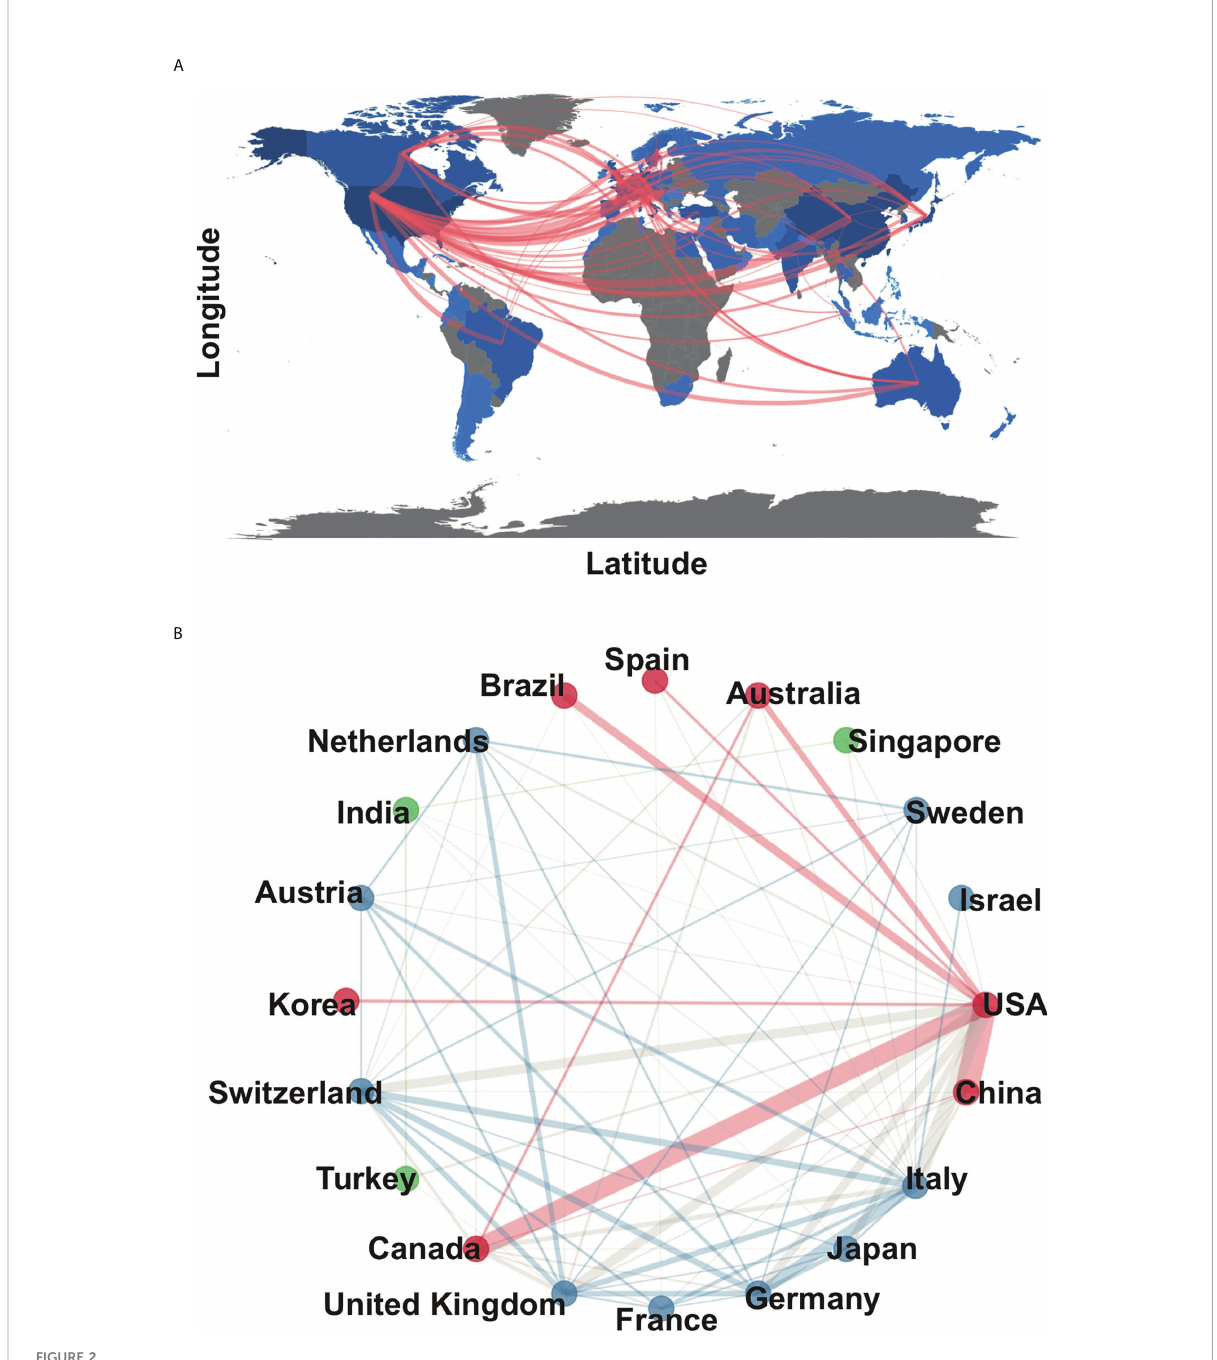
FIGURE 2 Main countries/regions of chordoma research and collaboration. (A) Countries/regions distribution of chordoma research and collaboration map; (B) collaboration network of 20 countries/regions in chordoma